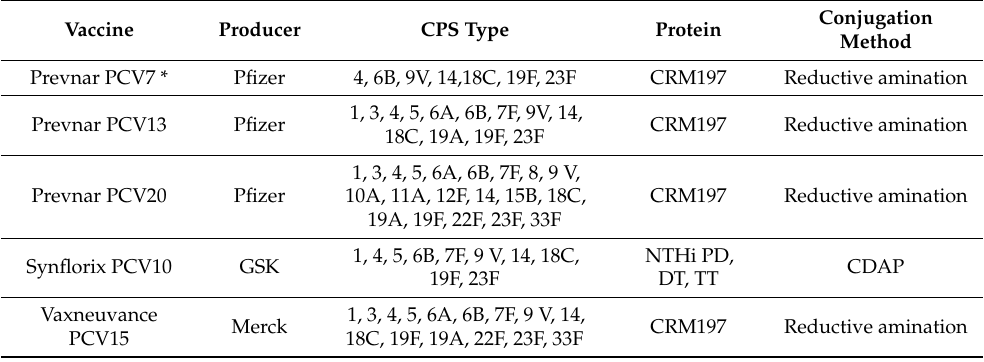
Table 1. Currently used PCVs approved by FDA and/or EMA. * Displaced by PCV13. Abbrevia- tions: TT, tetanus toxoid; CRM197, cross-reactive material 197; NTHI PD, non-typeable Haemophilus influenzae protein D; DT, diphtheria toxoid; FDA, Food and Drug Administration; EMA, European Medicines Agency; GSK GlaxoSmithKline. References